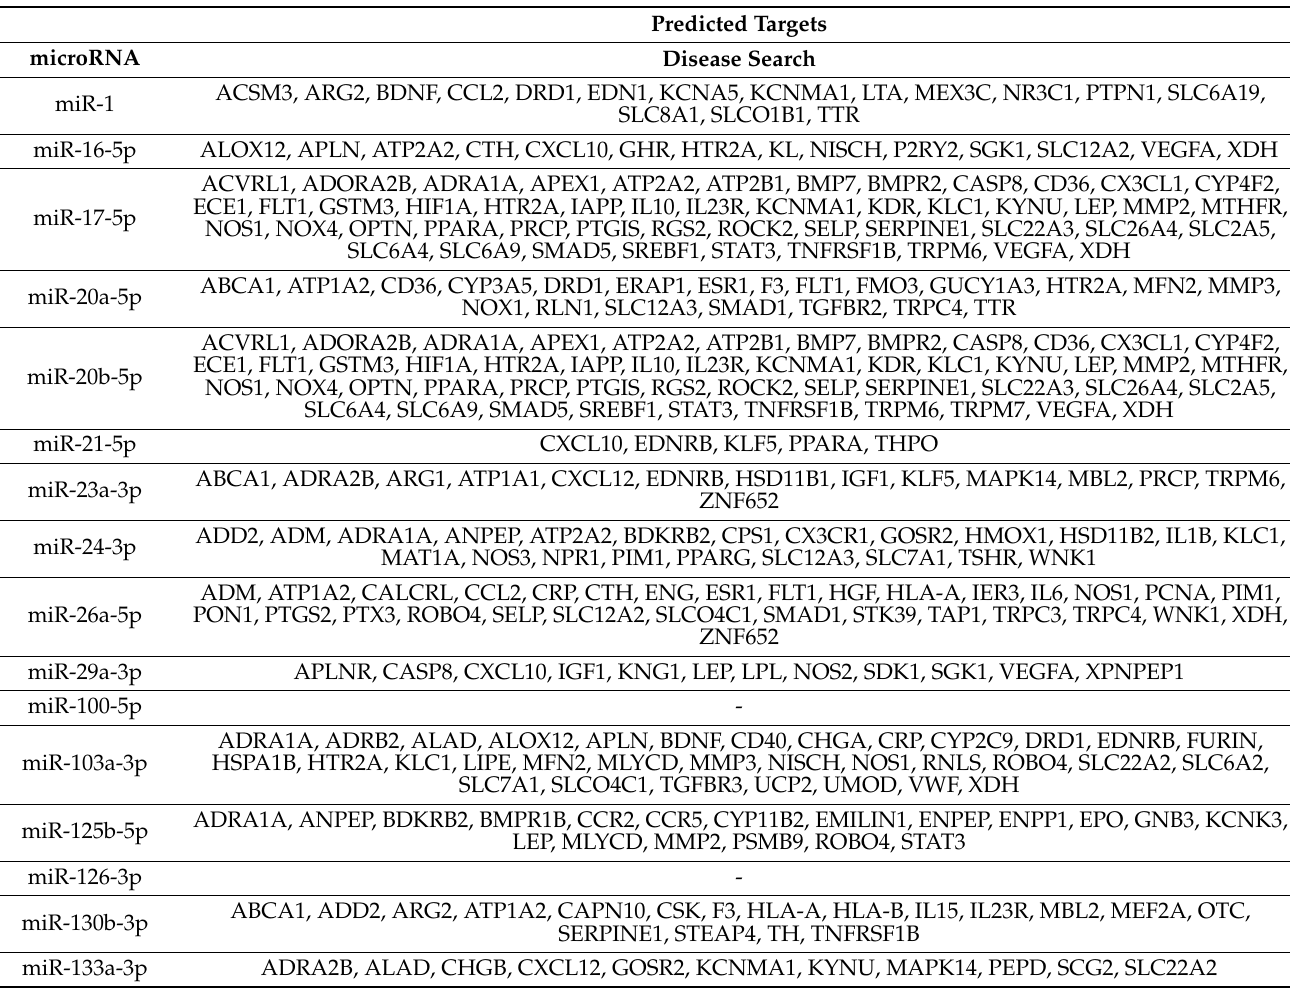
Table 7. A list of predicted targets of microRNAs dysregulated in the whole peripheral blood of preterm-born children in relation to hypertension, using the miRWalk2.0 database (data available in the Disease Search